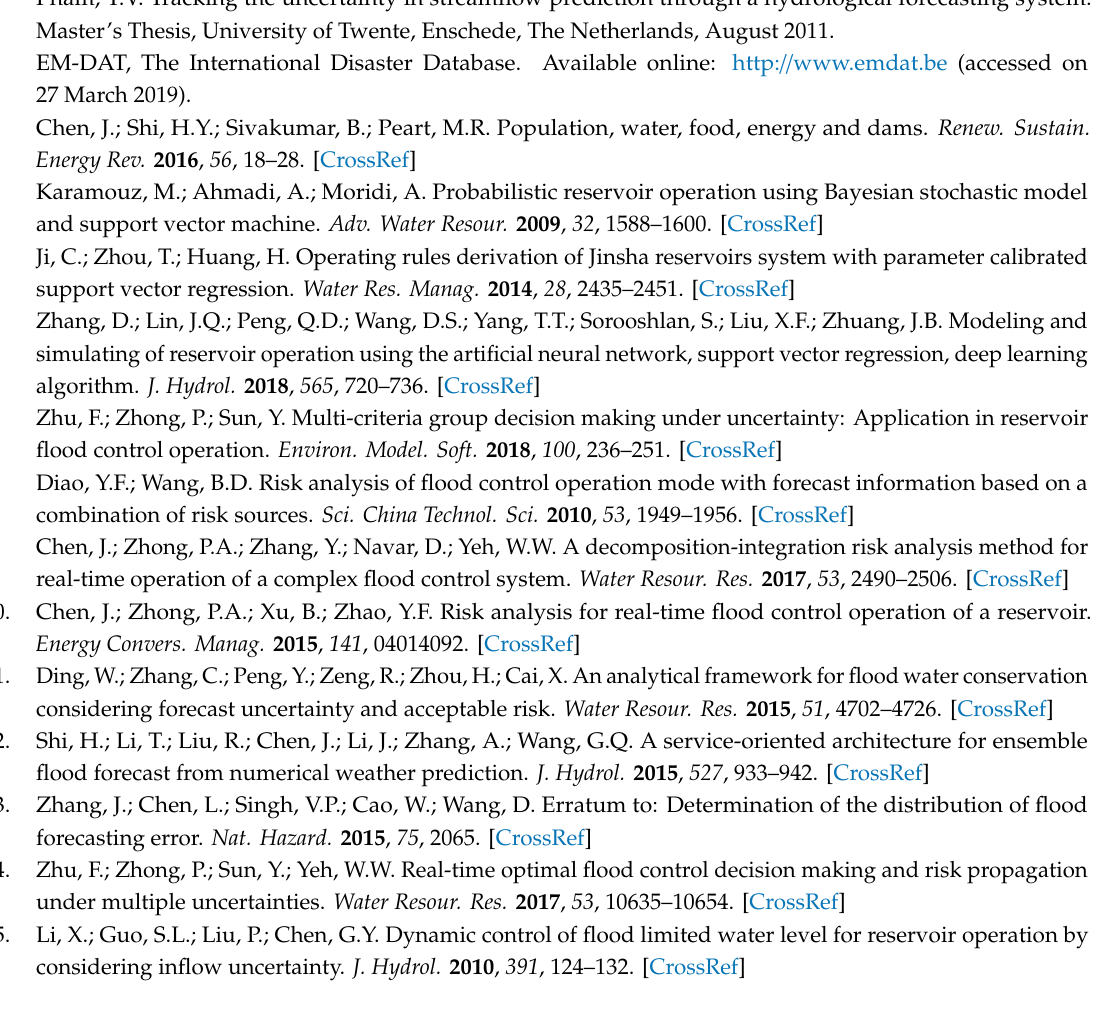
Figure S1: Schematics of the combined simulation-optimization model of multi-reservoir joint flood control operation. Table S1: The form of the operation scheme of multi-reservoir joint flood control. Table S2: The range of the decision variable of the optimization model. Table S3: Multi reservoir joint flood control operation Scheme 1 in the upper reach of Yangtze River. Table S4: Multi reservoir joint flood control operation Scheme 2 in the upper reach of Yangtze River. Table S5: Multi reservoir joint flood control operation Scheme 3 in the upper reach of Yangtze River. Table S6: Multi reservoir joint flood control operation Scheme 4 in the upper reach of Yangtze River. Table S7: Multi reservoir joint flood control operation Scheme 5 in the upper reach of Yangtze River. Table S8: Multi reservoir joint flood control operation Scheme 6 in the upper reach of Yangtze River. Table S9: Multi reservoir joint flood control operation Scheme 7 in the upper reach of Yangtze River. Table S10: Multi reservoir joint flood control operation Scheme 8 in the upper reach of Yangtze River. Table S11: Multi reservoir joint flood control operation Scheme 9 in the upper reach of Yangtze